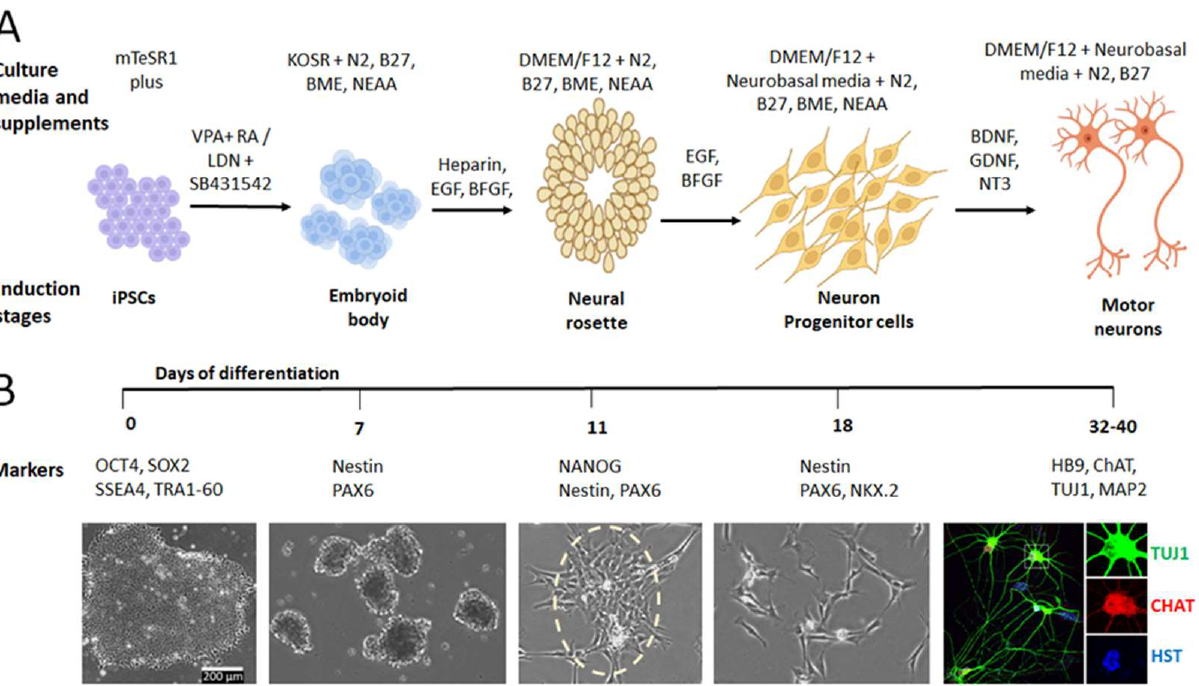
Figure 1. Generation of iPSC-derived MNs. ( A ) Schematic shows the process of generating iPSC- MNs. The culture media with different supplements are shown at different induction stages. ( B ) The timeline of the induction process from hiPSC to MNs. At each stage, specific markers and typical cellular morphology are shown. Image of MNs was adapted from [32] .